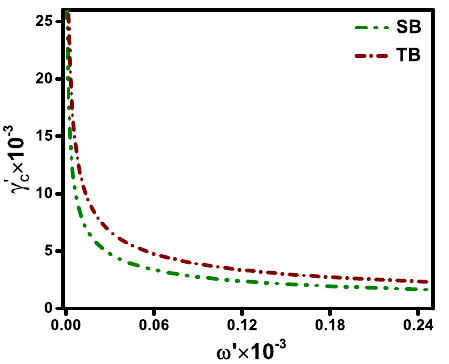
Figure 8. Spectrum of critical impurity versus SB and TB SP